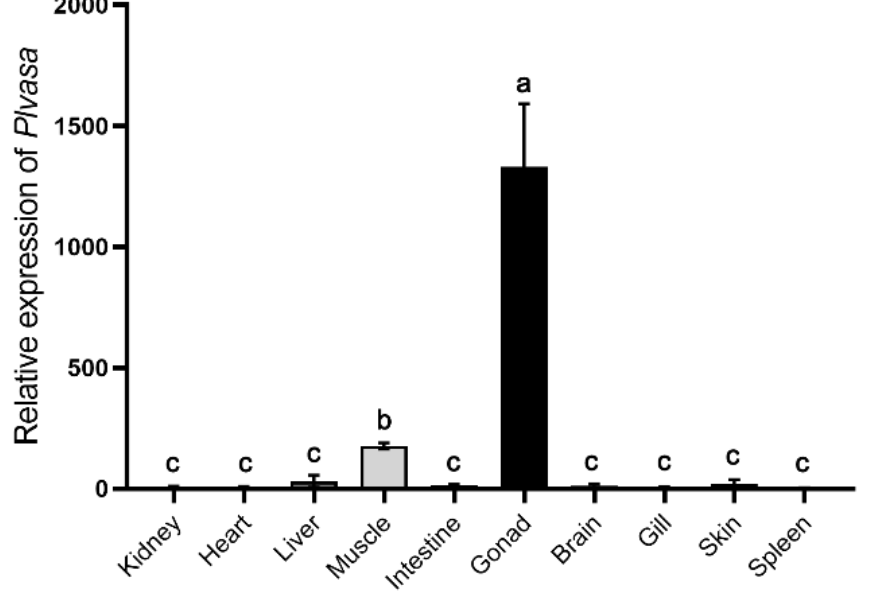
Figure 4. Analysis of Plvasa expression patterns at the level of mRNA in gonads of leopard coral grouper ( Plectropomus leopardus ) by qRT-PCR. The rpl13 and b2m were used as double internal reference genes to exhibit the expression level of Plvasa mRNA in different tissues, including kidney, heart, liver, muscle, intestine, gonad, brain, gill, skin and spleen. Relative expression was calculated by the 2 − ∆∆ Ct method. Data are shown as mean ± SD. Letters (a, b and c) reveal statistical significance ( p < 0.05), which was calculated by one-way analysis of